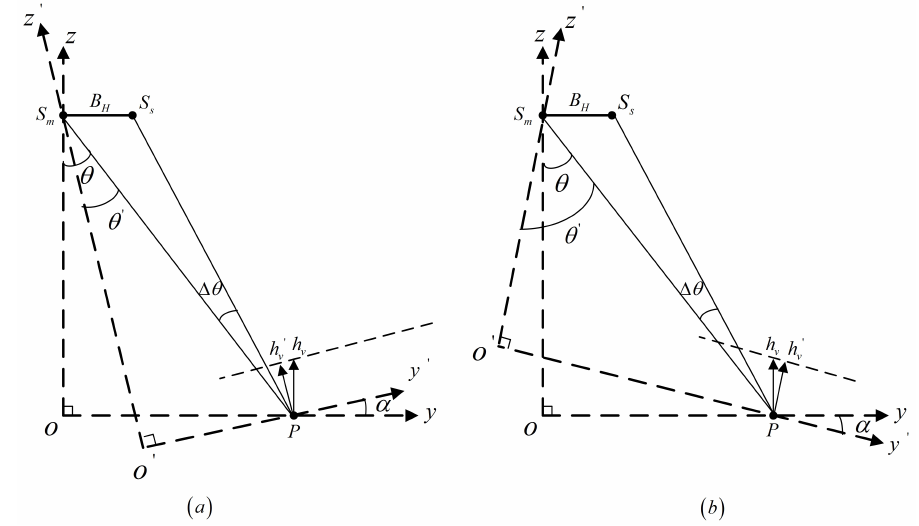
Figure 3. The interferometric acquisition geometry with range terrain slope: ( a ) The positive terrain slope and ( b ) the negative terrain slope. α is the range terrain slope, S m and S s are the master and slave antennas respectively, B H is the horizontal baseline, θ is the incidence angle, ∆ θ is the difference of incidence angle between master and slave antennas, θ (cid:48) is the local incidence angle, yoz and y (cid:48) o (cid:48) z (cid:48) are the original and corrected coordinate system respectively, h v (cid:48) is the forest height estimation in the corrected coordinate system, and h v is the final